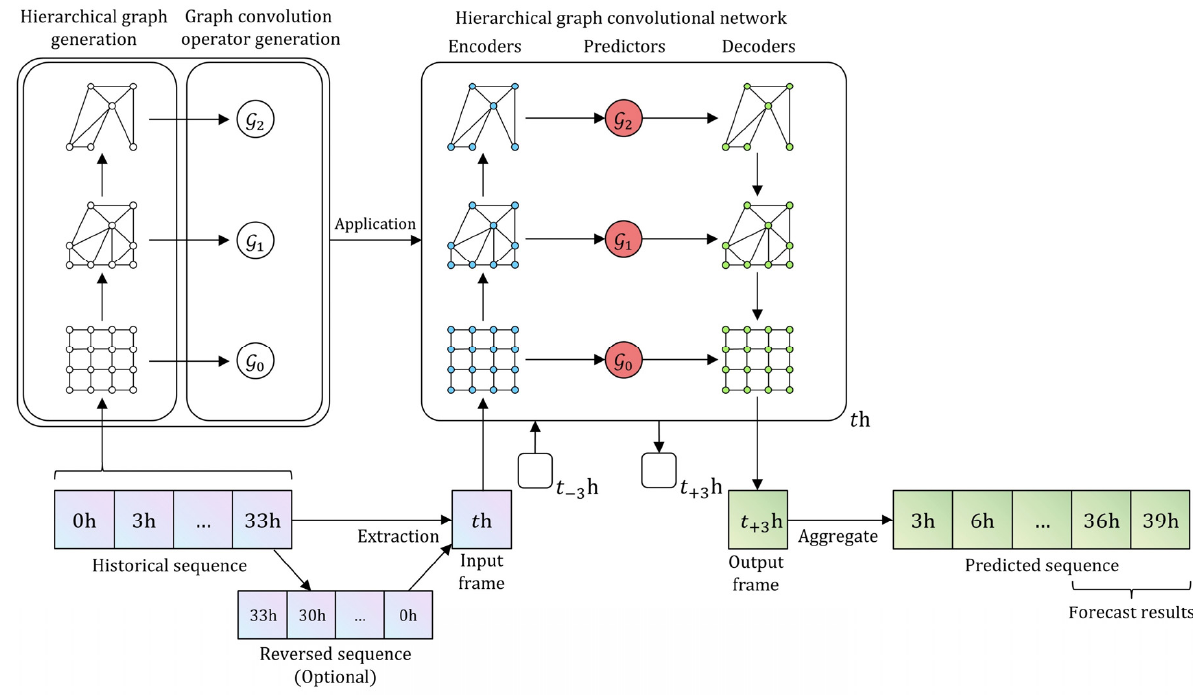
Figure 2. The overall architecture of the proposed Hierarchical Dynamic Graph Network (HDGN) model. It consists of three main modules: hierarchical graph generation, graph convolution operator generation, and Hierarchical Graph Convolutional Network (HGCN). The model is dynamic in nature because it uses different graphs for different sequences.